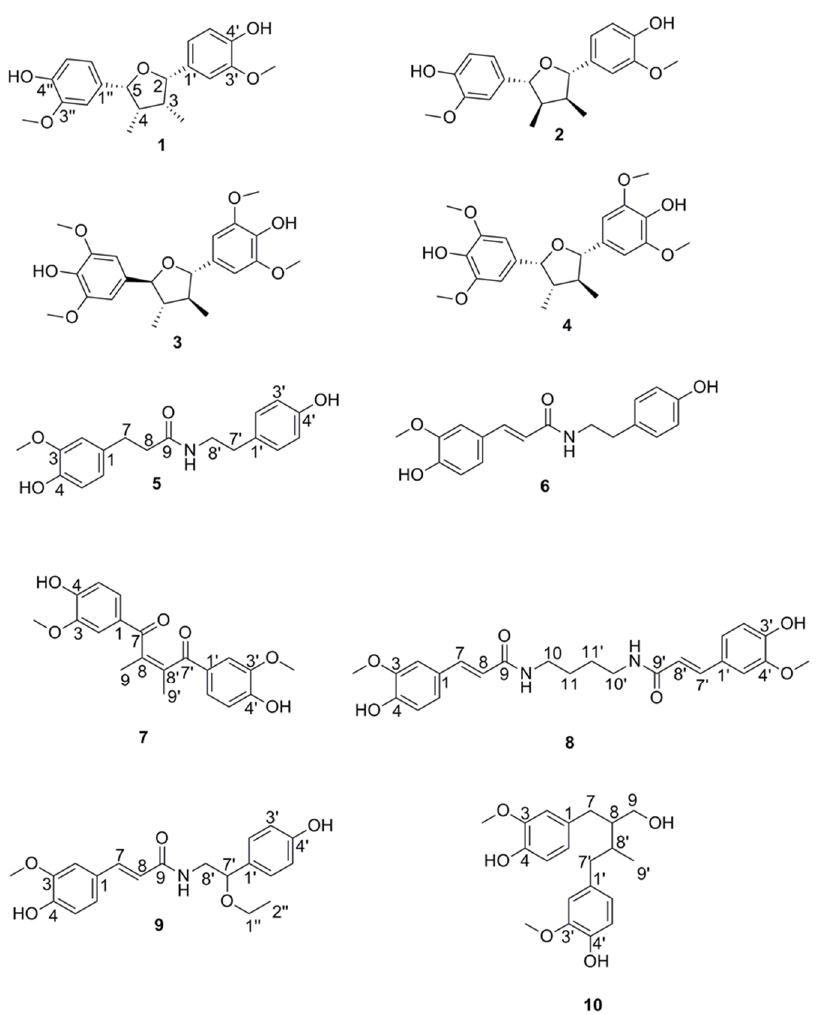
Figure 3. Chemical Structures of tetrahydrofuroguaiacin B ( 1 ), nectandrin B ( 2 ), fragransin B 2 ( 3 ), fragransin B 1 ( 4 ), dihydro-feruloyltyramine ( 5 ), ( E )- N -feruloyltyramine ( 6 ), furoguaiaoxidin ( 7 ), N , N ′ -diferuloylputrescine ( 8 ), 7 ′ -ethoxy-feruloyltyramine ( 9 ), and 3,3 ′ -dimethoxy-4,4 ′ -dihydroxylignan-9-ol ( 10 ).